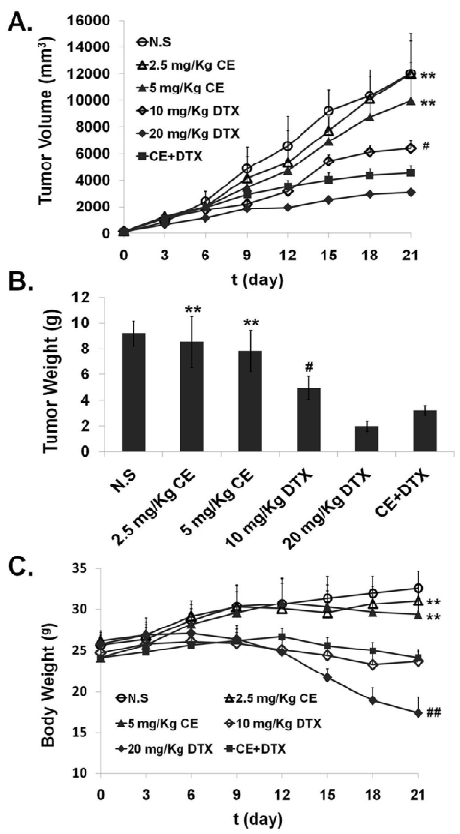
Figure 8. Antitumor effects of CE + DTX on B16 tumor-bearing mice after intravenous administration ( n = 5). 2.5/5 mg/kg CE, 10/20 mg/kg DTX and N.S were served as controls. ( A ) Tumor volume; ( B ) Tumor weight; ( C ) Body weight. ** p < 0.01, statistically significant difference between CE and CE + DTX; # p < 0.05, ## p < 0.01, statistically significant difference between DTX and CE +